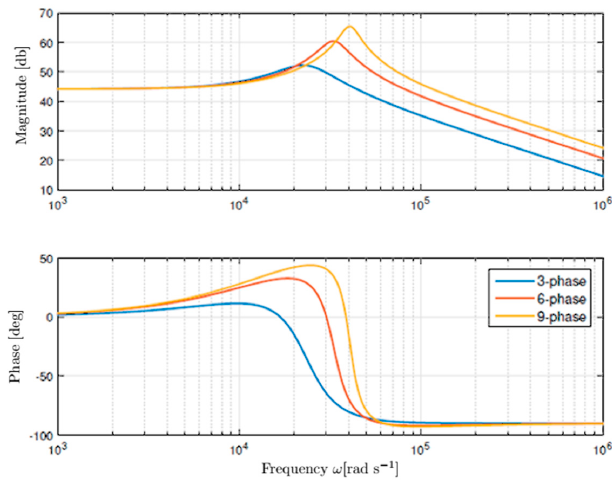
Figure 2. Energies 2020 , 13 , x FOR PEER REVIEW